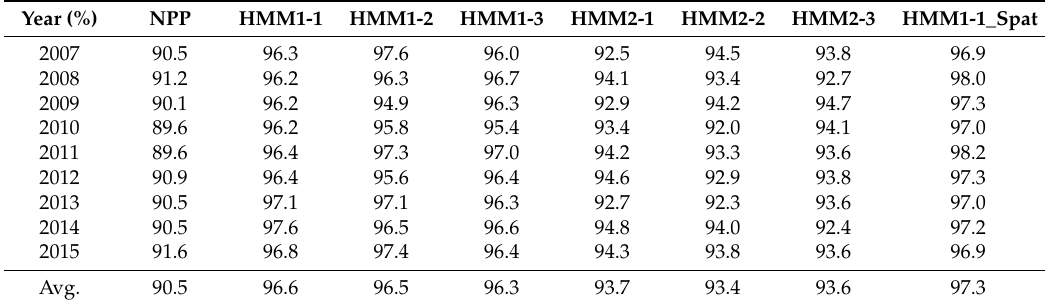
Table 4. Average classification accuracy of all plans by 5-fold cross